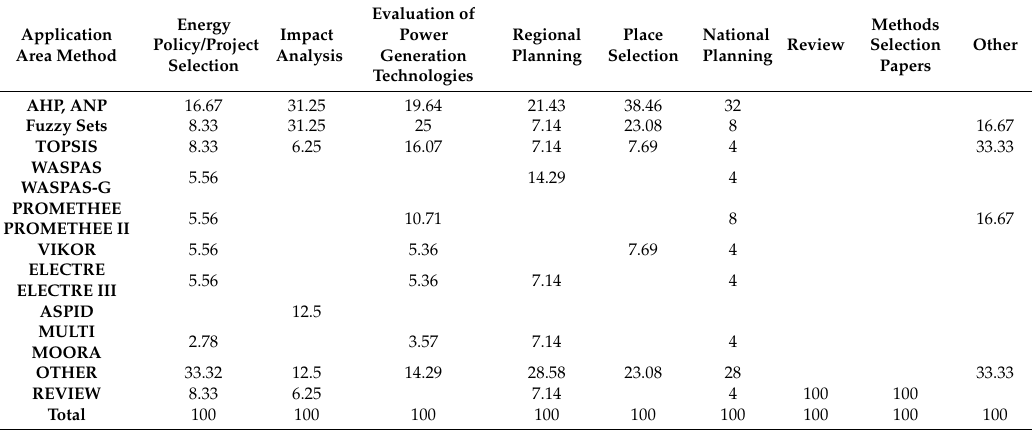
Table 5. The distribution of methods by application areas, %.